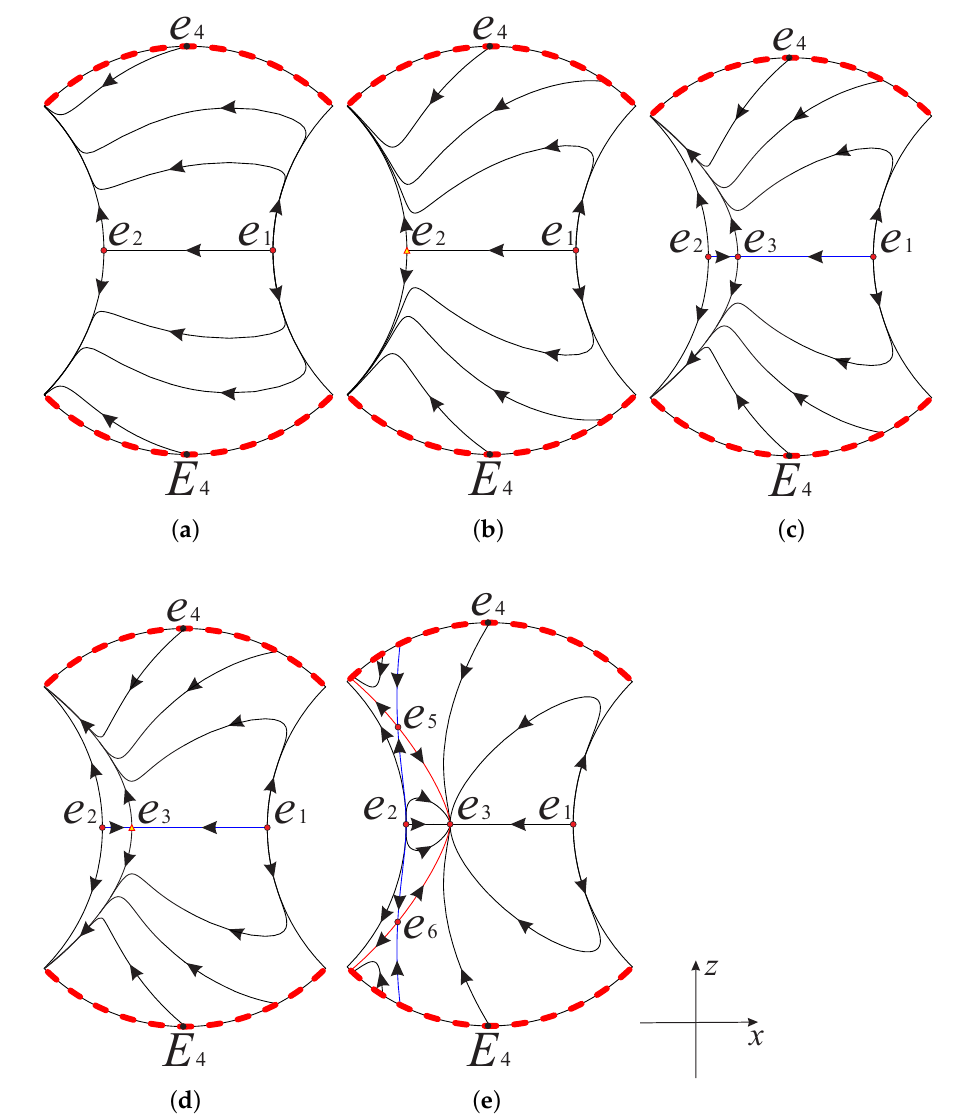
Figure 4. The phase portrait on the invariant plane u = 0 restricted to the region x 2 − z 2 ≤ 1 inside the Poincaré disc for different values of s : ( a ) s < ( d ) s = − 1, ( e ) − 1 < s < 0. Here E 4 is the diametrically opposite equilibrium point of e 4 at